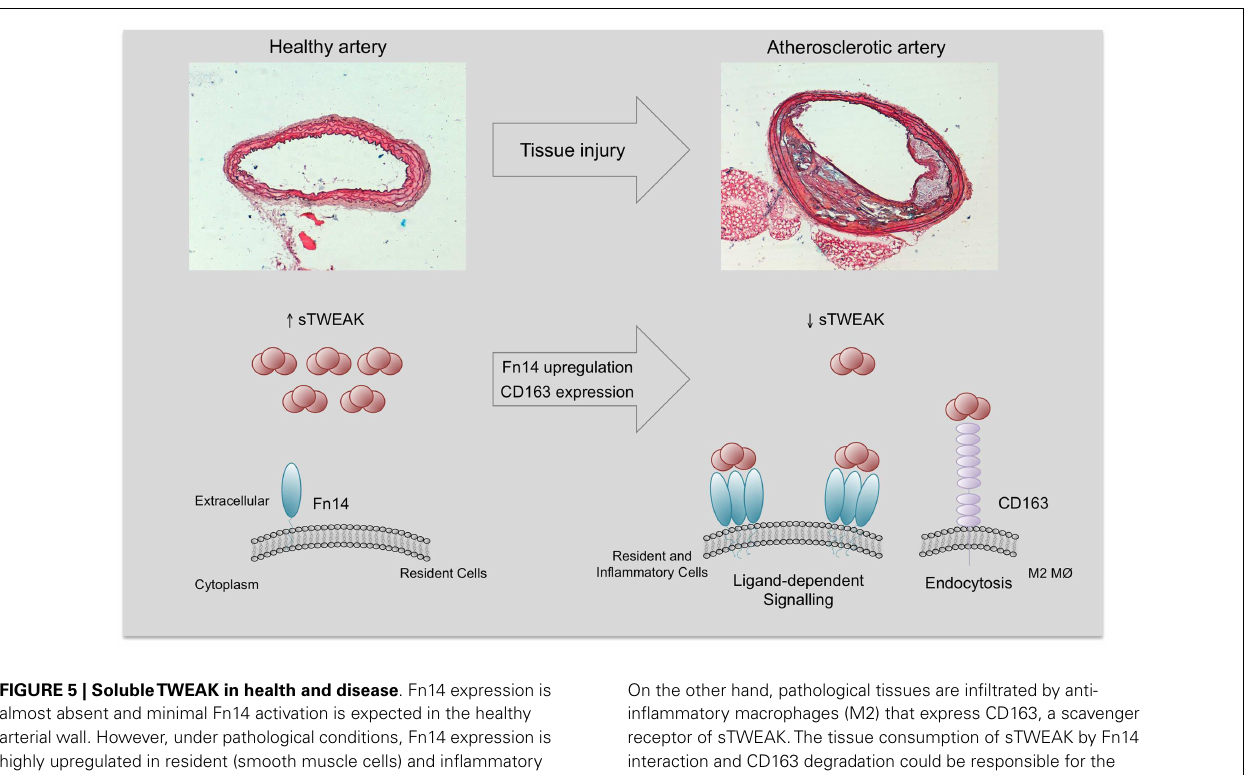
FIGURE 5 | SolubleTWEAK in health and disease . Fn14 expression is almost absent and minimal Fn14 activation is expected in the healthy arterial wall. However, under pathological conditions, Fn14 expression is highly upregulated in resident (smooth muscle cells) and inflammatory cells (e.g., M1 macrophages).This increase facilitates the interaction with sTWEAK and would trigger sTWEAK-dependent Fn14 signaling.